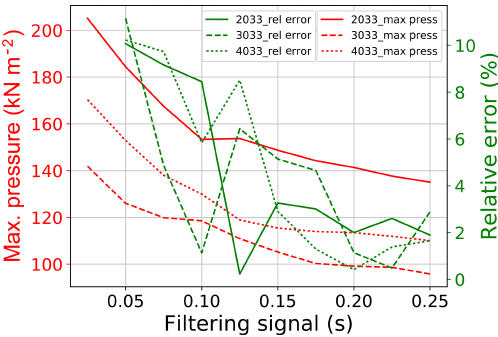
Figure 9. Maximum impact pressure and its corresponding relative error for different values of the filtering interval. Results for 2033 indicates a simulation with φ b = 20 ◦ and